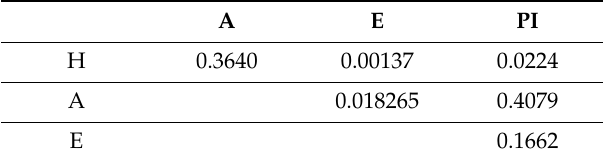
Table 5. P-values resulting from the Mann-Whitney U test for group comparisons using